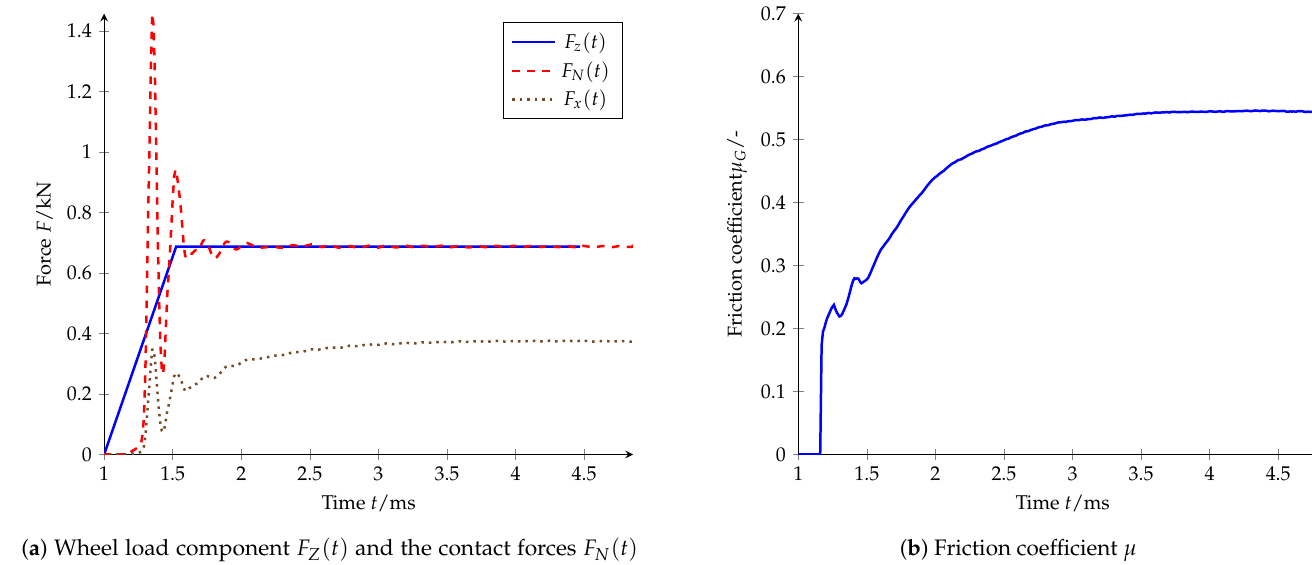
and F x ( t ) . Figure 16. Simulation results for pattern BB at 140kmh − 1 and the parameters described in Table